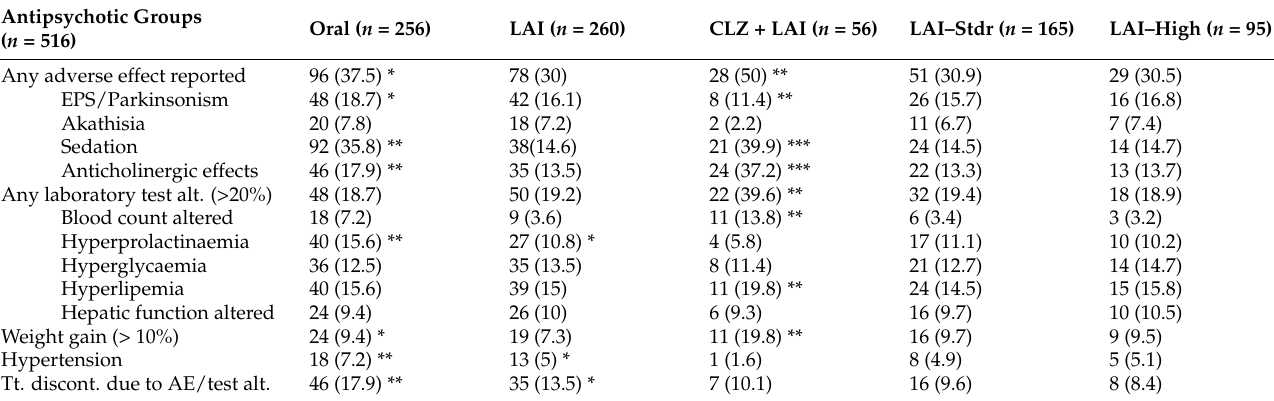
Table 4. Adverse effects reported, laboratory tests, and weight [ n